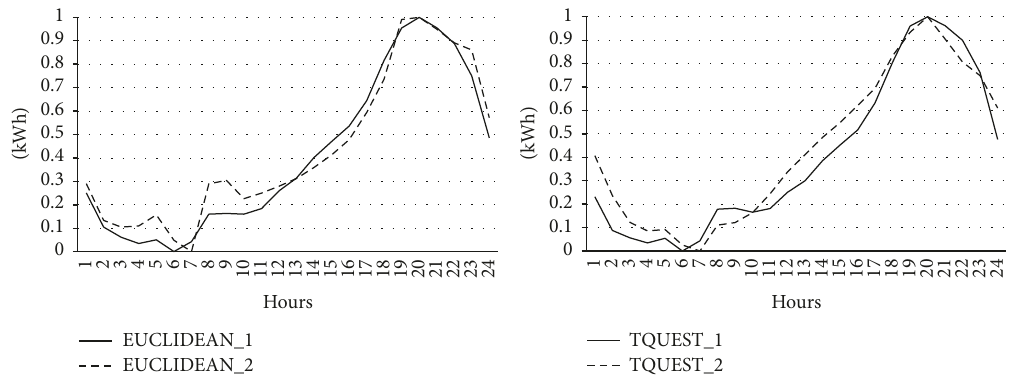
Figure 4: Normalized average hourly load profiles for partition 1 containing 2 clusters.